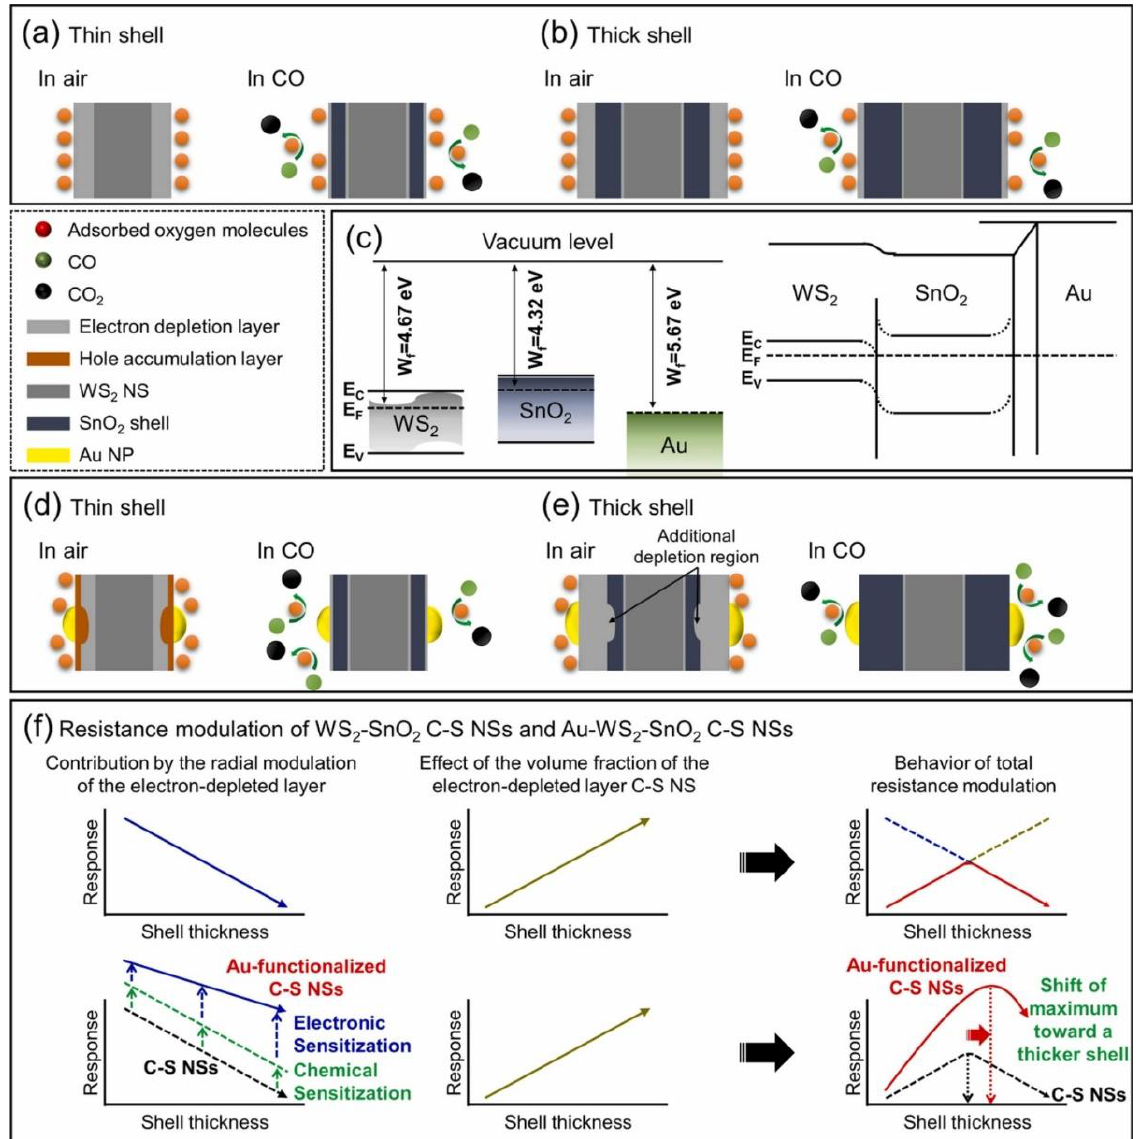
Figure 11. Gas-sensing mechanism of ( a ) thin-shell and ( b ) thick-shell pristine WS 2 – SnO 2 core – shell NSs. ( c ) Energy bands of Au-functionalized WS 2 – SnO 2 core – shell NSs before and after contact. Gas-sensing mechanism of ( d ) thin-shell and ( e ) thick-shell Au-decorated WS 2 – SnO 2 core – shell NSs. ( f ) Resistance modulation of pristine and Au-decorated WS 2 – SNO 2 core – shell NS gas sensors. Reprinted with permission from Ref. [112]. Copyright 2022, Elsevier.